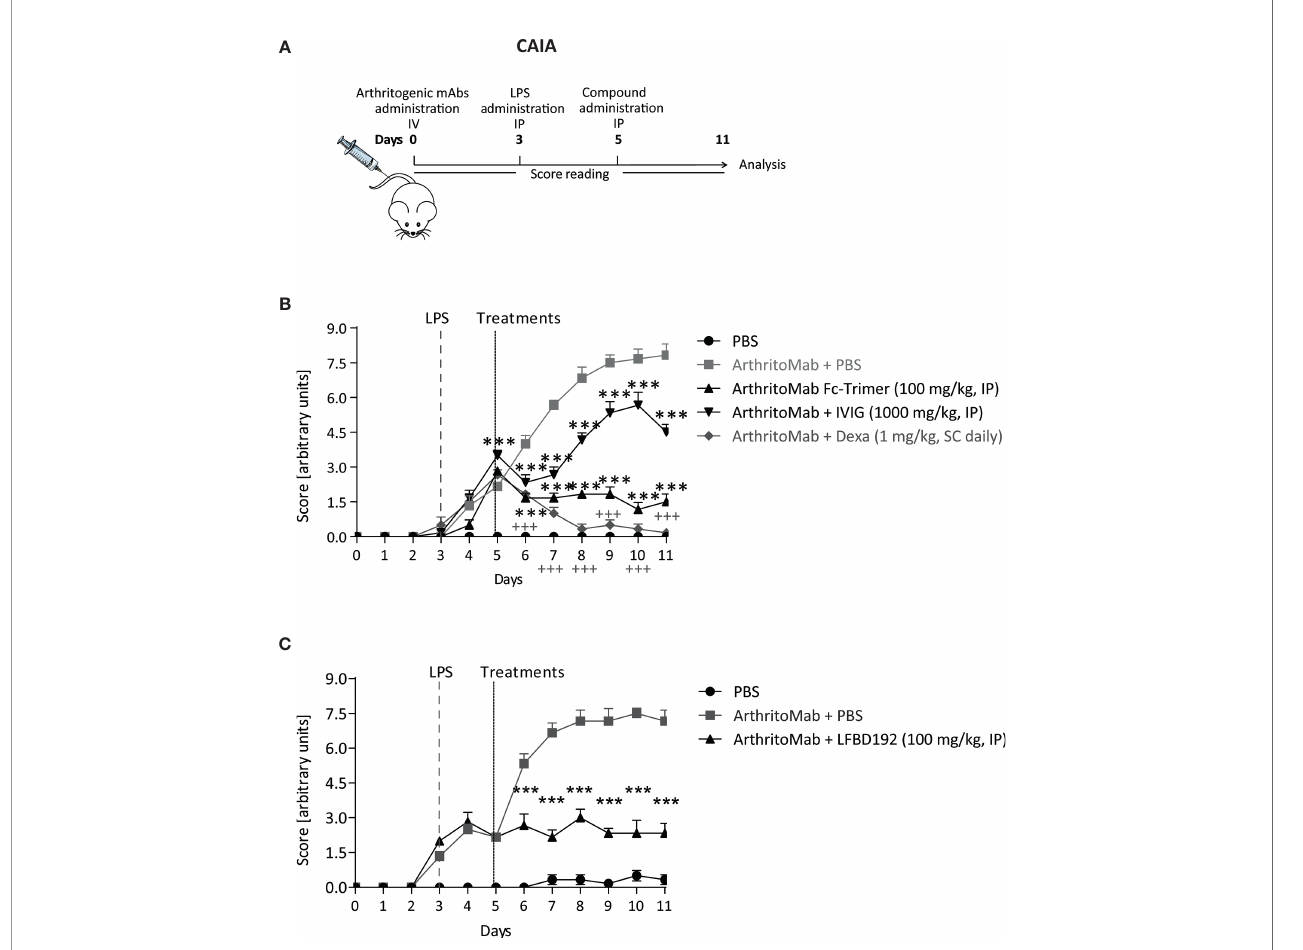
FIGURE 9 | LFBD192 displayed high potency in a mouse model of collagen antibody-induced arthritis (CAIA). (A) Schematic representation of the mouse model of CAIA with administration of the compound 5 days after anti-collagen antibody injection. (B) Clinical scores after treatment with PBS, the Fc-trimer (100 mg/kg), IVIg (1,000 mg/kg), and dexamethasone (1 mg/kg, daily). (C) Clinical scores after treatment with PBS and LFBD192 at 100 mg/kg. Data represent the means ± SEM of 6 mice per group. Statistical evaluation of the differences among the experimental groups was performed using two-way ANOVA followed by Bonferroni ’ s post-test. P - values <0.05 were considered signi fi cant. +++ p <0.001, Vehicle compared with CAIA + Vehicle; * p <0.05, ** p <0.01, *** p <0.001, **** p <0.0001: compared with CAIA + vehicle. All the statistical analyses were performed using GraphPad Prism version 8 for Windows (GraphPad Software